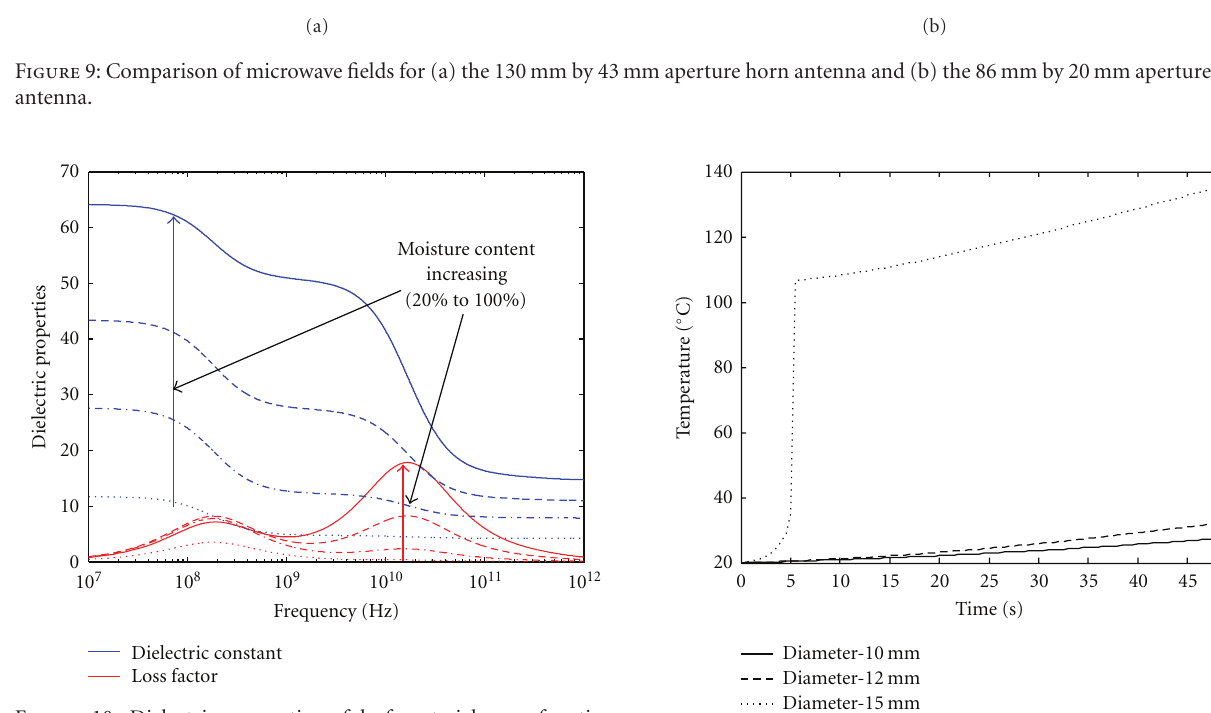
Figure 10: Dielectric properties of leaf material as a function of frequency and gravimetric moisture content based on models developed by Chuah et al. [63].